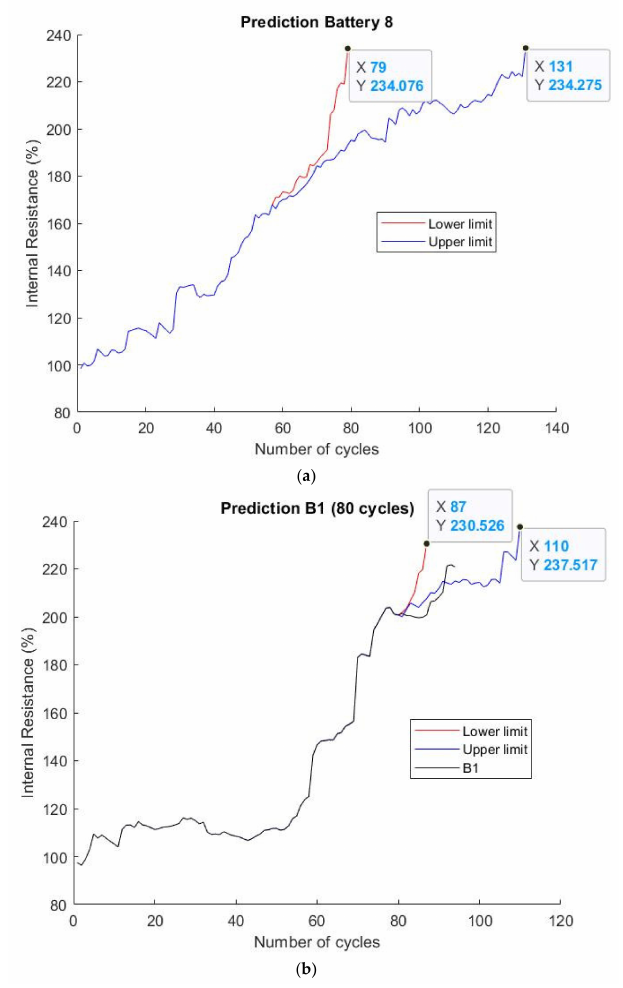
Figure 28. Prediction of life for batteries in use: ( a ) cell 8; ( b ) cell